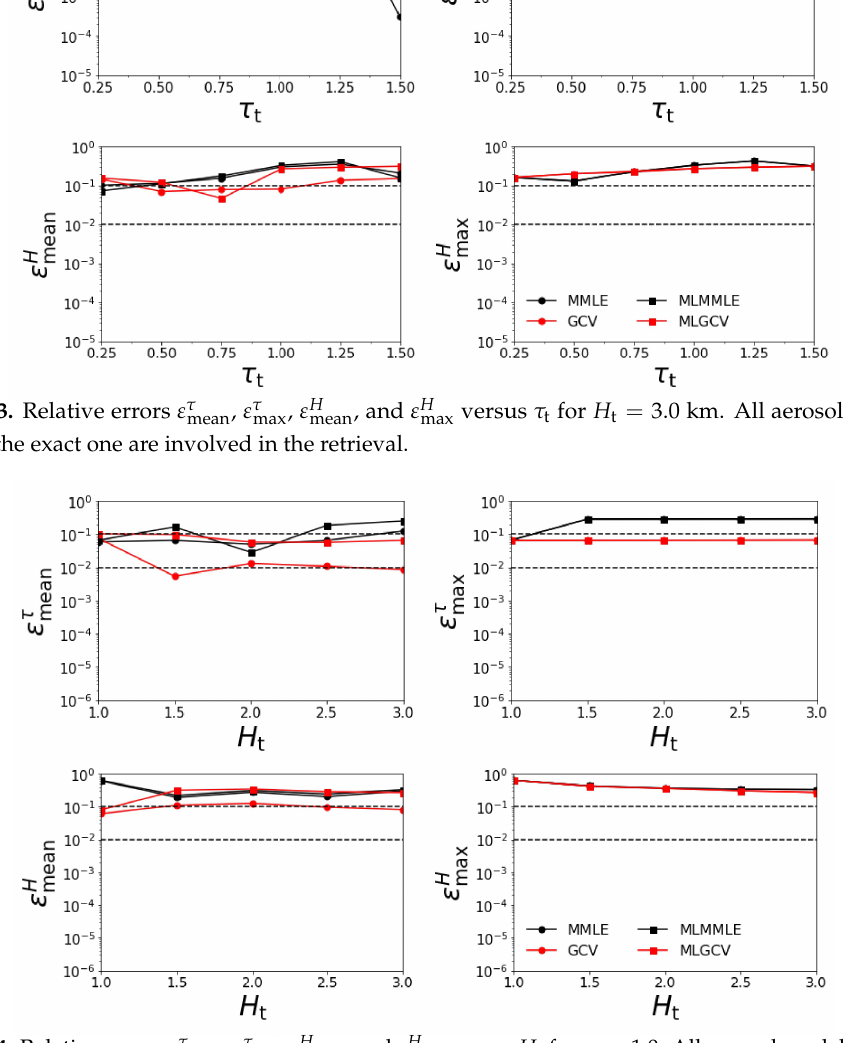
Figure 4. Relative errors ε τ mean , ε τ max , ε H mean , and ε H max versus H t for τ t = 1.0. All aerosol models except the exact one are involved in the